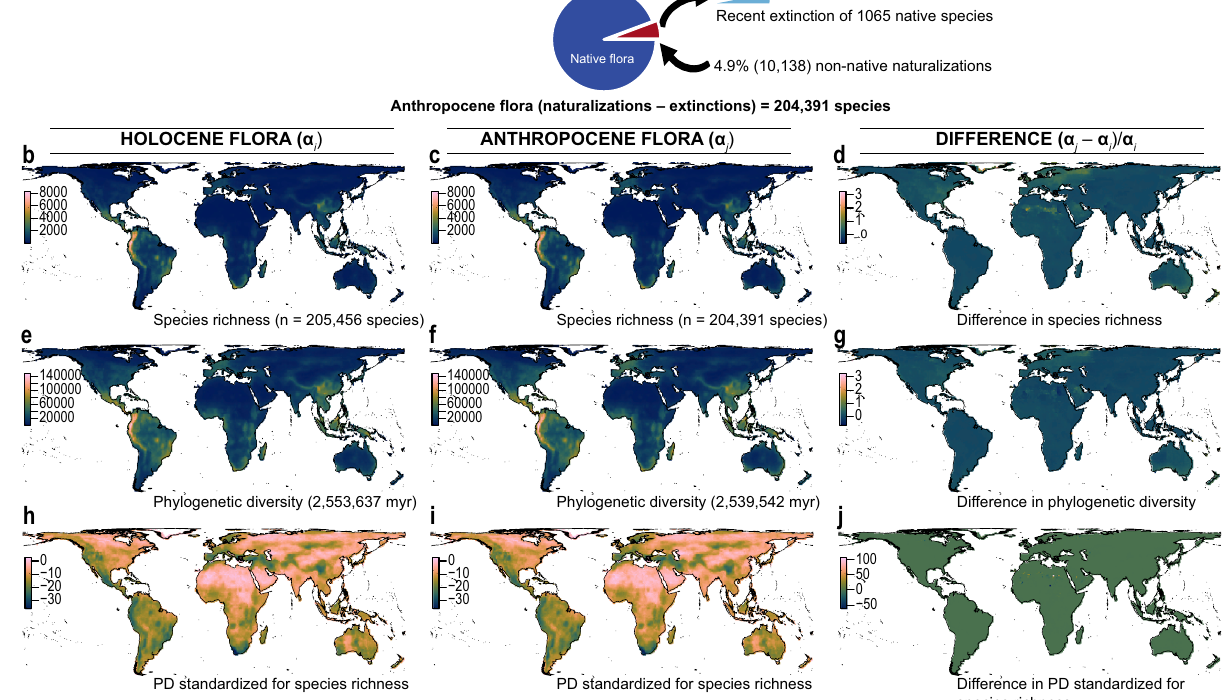
Fig. 1 Temporal and spatial changes in α -diversity across plant communities in the Anthropocene based on recent plant extinctions and naturalizations ( best case scenario). Left panel shows the Holocene fl ora, middle the Anthropocene fl ora (based on recent extinctions and naturalizations) and right panel differences between Holocene and Anthropocene fl oras. a Schematic of the Anthropocene fl ora showing recent extinctions replaced by non-native naturalizations. b – d Spatial and temporal changes in species ( α ) diversity. e – g Spatial and temporal changes in observed phylogenetic ( α ) diversity. h – j Spatial and temporal changes in phylogenetic ( α ) diversity standardized for species richness (phylogenetic tip shuf fl ing 1000 times). Species diversity was calculated as the numbers of species within 100 km × 100 km grid cells (see Supplementary Fig. 1 for a different spatial scale). Phylogenetic diversity (PD) was calculated in million years (myr) as the sum of all phylogenetic branch lengths for the set of species within each grid cell. Species richness was corrected for by calculating the standardized effective size of phylogenetic ( α ) diversity based on 1000 randomizations (see Methods). Maps are in Behrmann equal-area